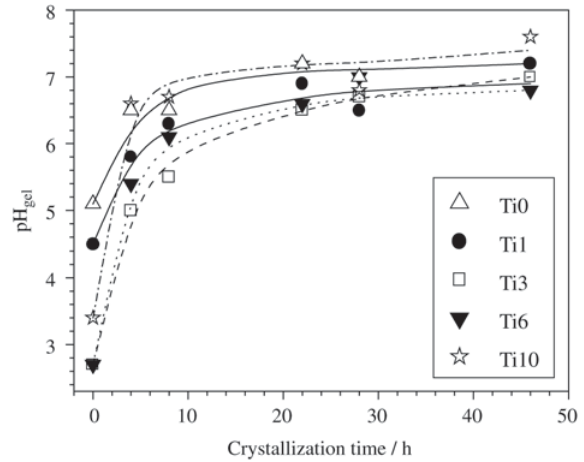
Figure 3. pH of the reaction mixture containing different Ti con- tents as a function of the crystallization time.